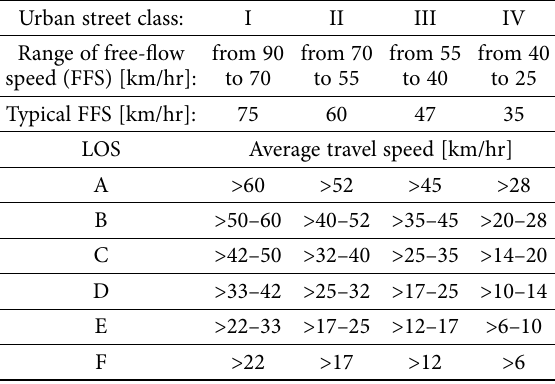
Table 2. Urban street speed ranges for different LOS proposed in Indian conditions by AP clustering method Urban street class: I II III IV Range of free-flow from 90 from 70 from 55 from 40 speed (FFS) [km/hr]: to 70 to 55 to 40 to 25 Typical FFS